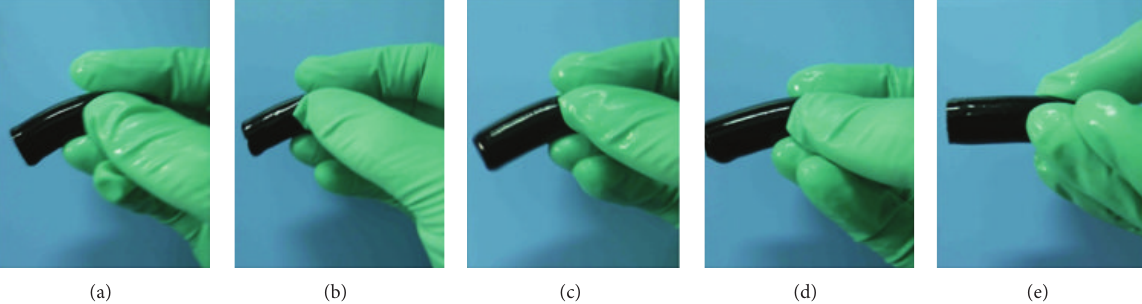
Figure 1: The appearance of cellulose/MWCNTs hydrogels with different weight ratios: (a) Gel 1 (20: 1), (b) Gel 2 (10: 1), (c) Gel 3 (4 :1), (d) Gel 4 (3 :1), and (e) Gel 5 (2: 1).